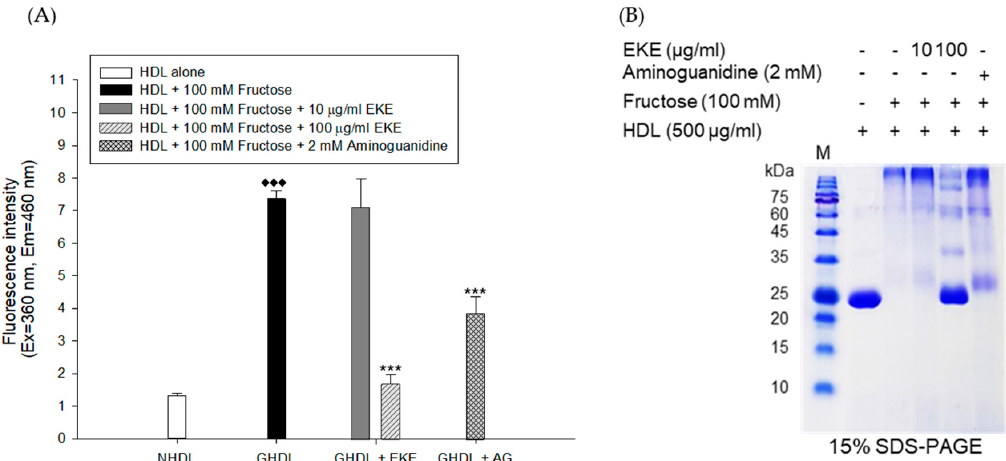
Figure 5. Effect of E. koreanum extract (EKE) on fructose induced HDL glycation. ( A ) The formation of AGEs was determined by measuring the fluorescence intensity (Ex = 360 nm, Em = 460 nm). ( B ) SDS-PAGE of HDL modified by 100 mM fructose for 72 h in the absence or presence of E. koreanum extract (final concentrations, 10 and 100 μ g/mL). These data are expressed as mean ± SD of three independent experiments. ♦♦♦ , p < 0.001 vs. NHDL (native HDL); ***, p < 0.001 vs. GHDL (glycated HDL).